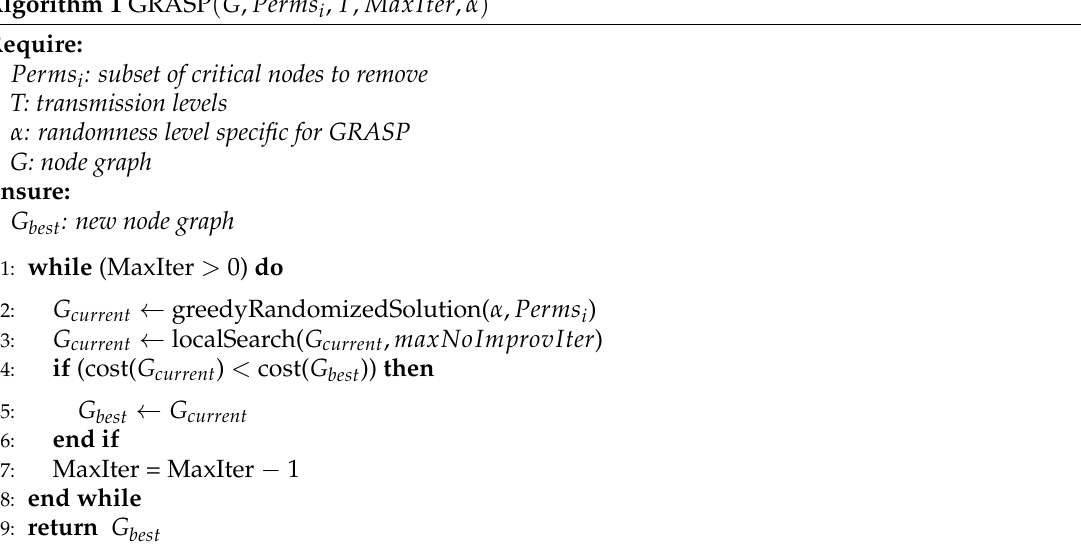
Algorithm 1 GRASP ( G , Perms i , T , MaxIter , α